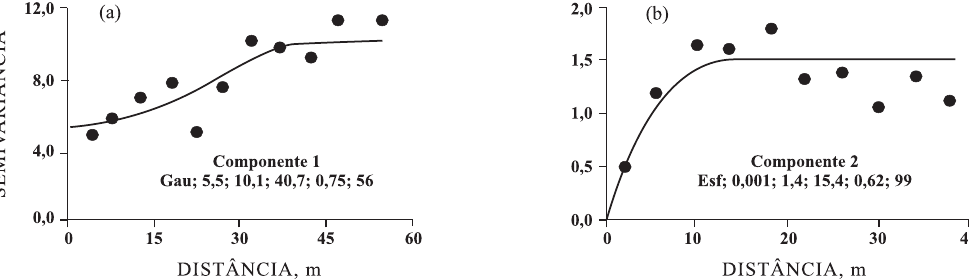
Figura 6. Modelos e parâmetros (C componente principal: a) gaussiano; b) esférico.